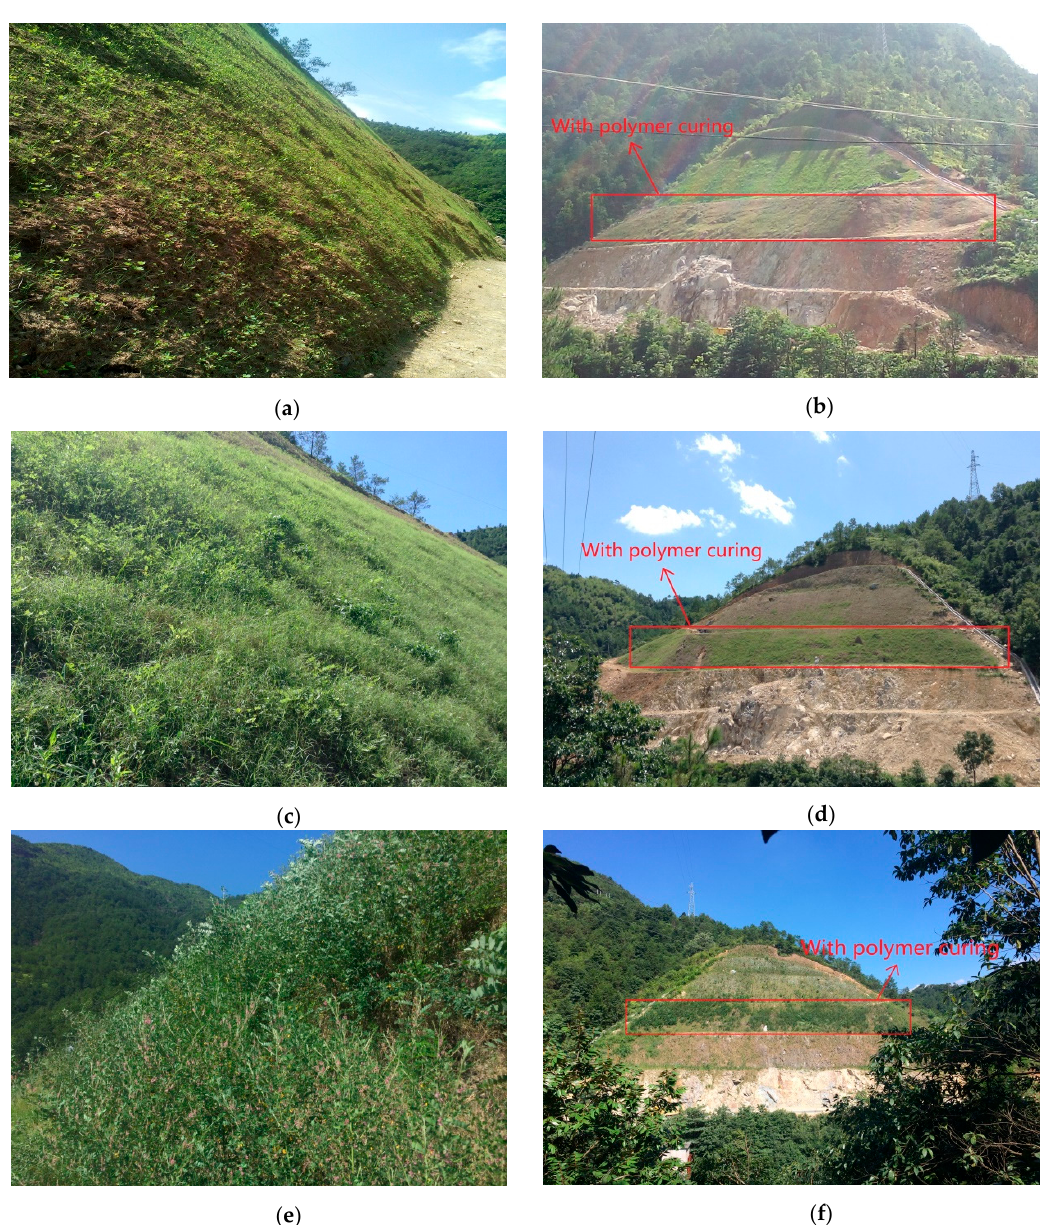
Figure 15. Plant growth conditions of the Zhejiang test slope: ( a – b ) 1 month later; ( c – d ) 3 months later; ( e – f ) 1 year and 3 months later.